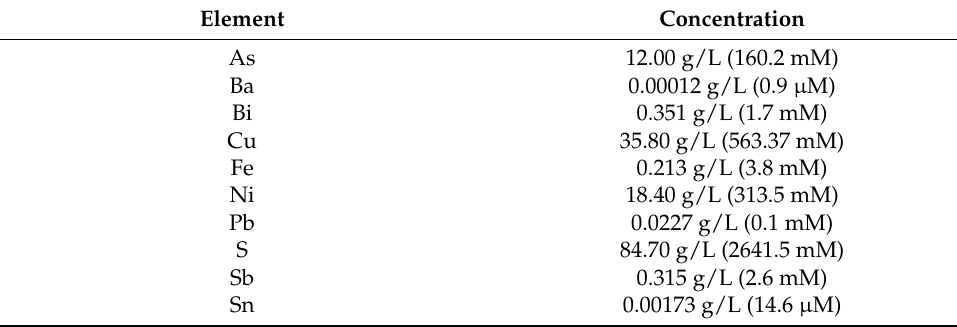
Table 4. Elemental composition of the industrial electrolytes used in the